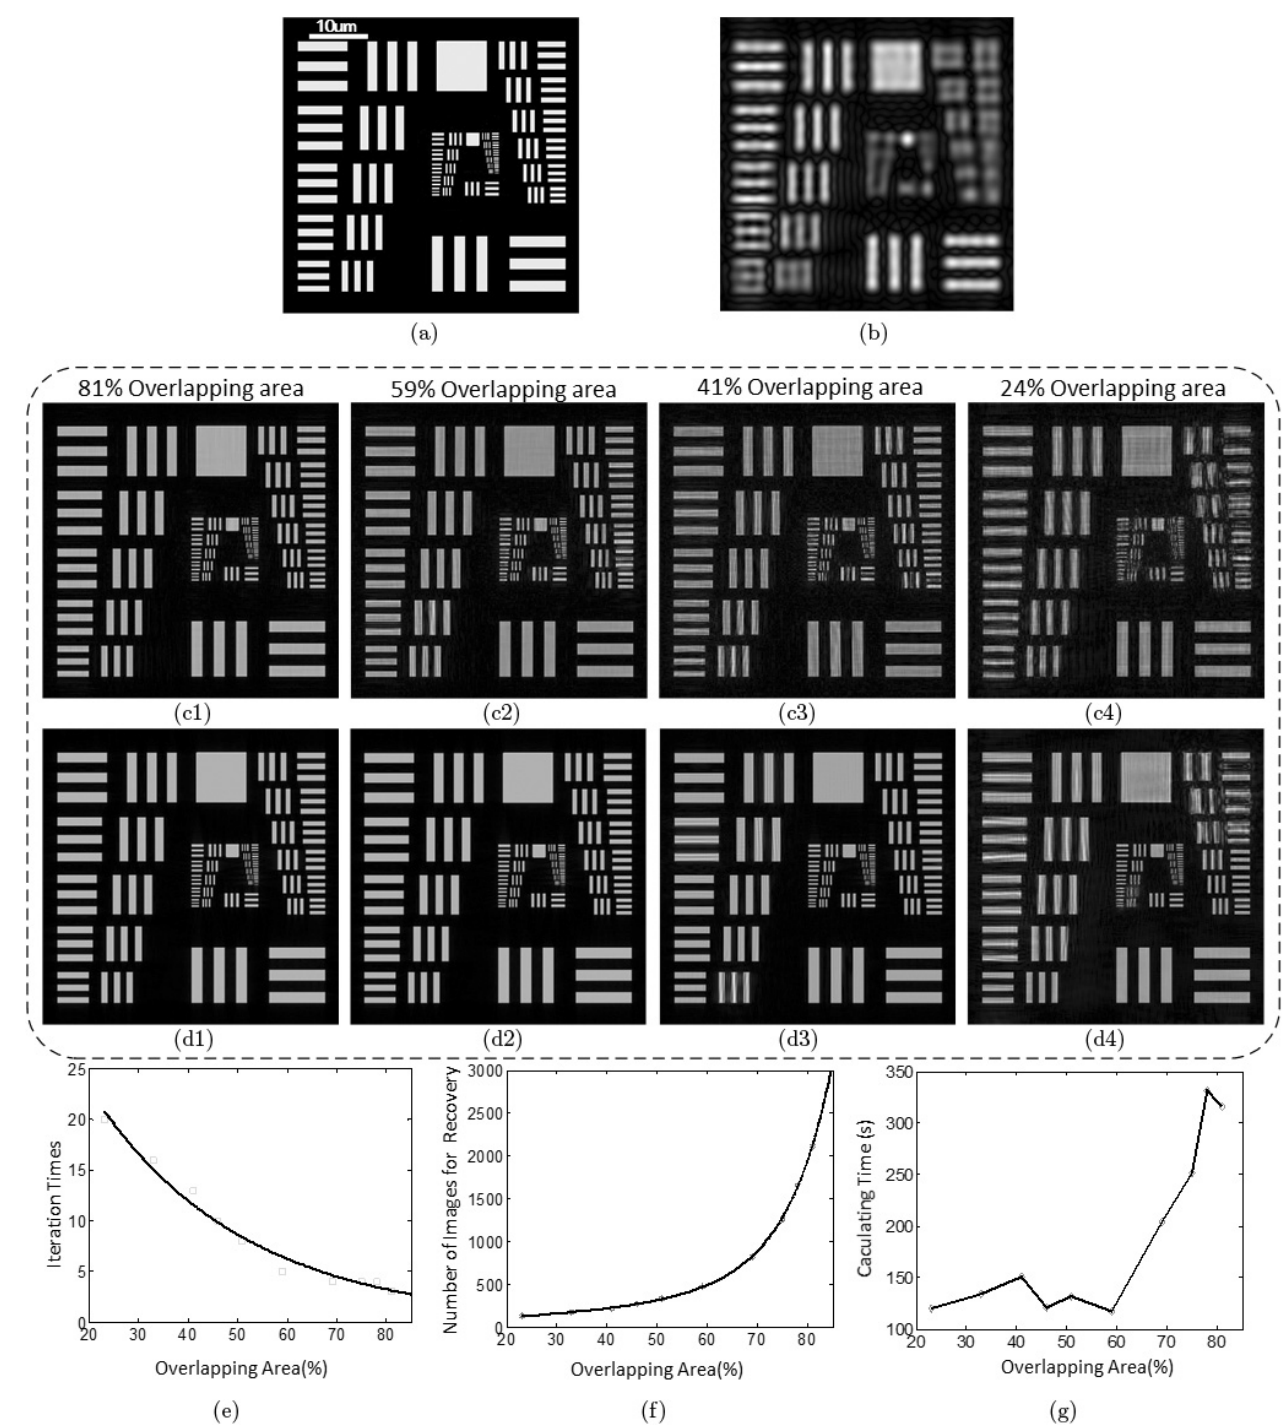
Fig. 5. Recovery of FPM with di®erent overlapping area of spectrum. (a) The input raw image of resolution target. (b) Obtained image with normal illumination. FPM recovered intensity by iterating (c) for once, and (d) until convergence, with 1.49 illuminating NA and 0.2 collecting NA applied. The corresponding overlapping areas for (c1) – (c4) and (d1) – (d4) are 81%, 59%, 41% and 24%, respectively. (e) The relationship between overlapping area and iterative times. (f) The number of images for FPM's recovery is plotted as a function of overlapping area. (g) The relationship between calculating time and overlapping